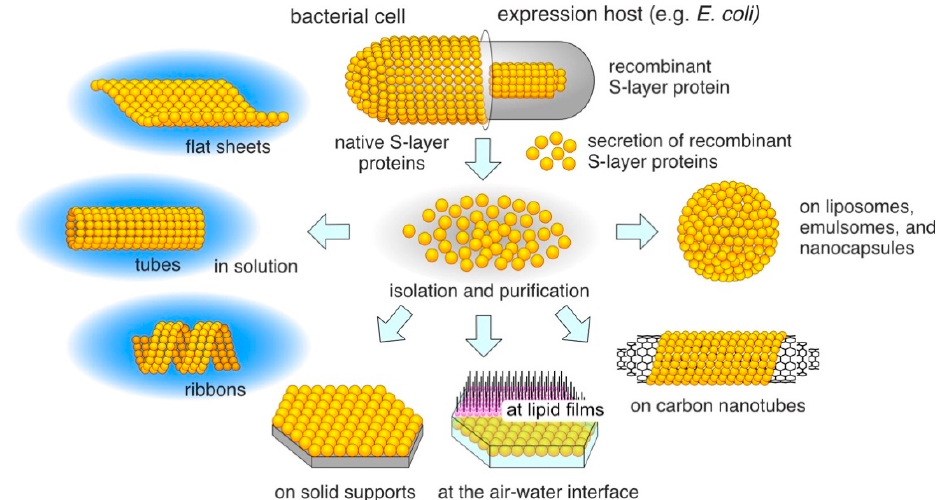
Figure 3. Schematic drawing of the different reassembly routes of S-layer proteins.